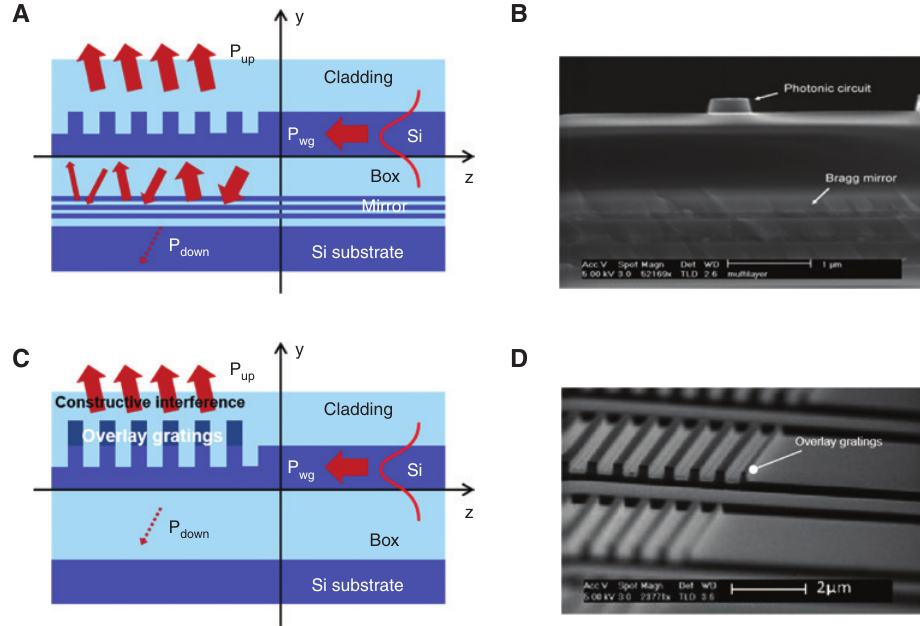
Figure 11: Diffraction grating-based optical coupling methods using directionality-enhanced grating structures. (A) Schematic diagram of a grating coupler with a backside mirror, enhancing the upward power (P image of an example of the substrate reflector structure. Reprinted from Ref. [127]. Copyright (2009) The Optical Society. (C) Schematic diagram of a grating coupler with an overlay grating structure to reduce leakage. (D) SEM image of an example of a silicon overlay structure. Reprinted from Ref. [112]. Copyright (2010) The Optical